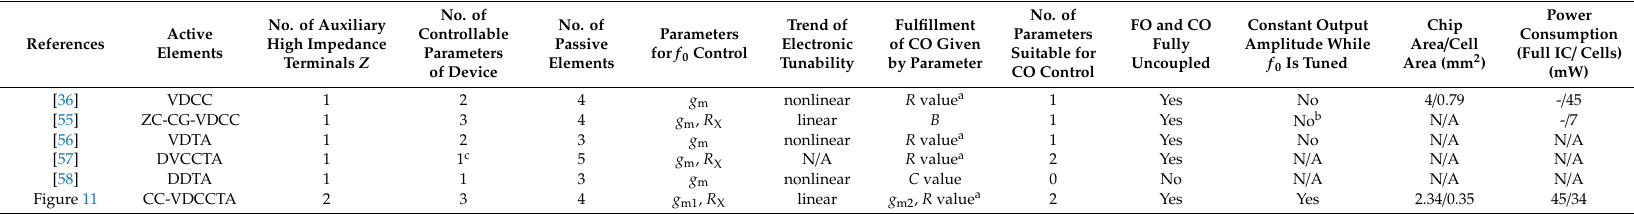
Table 2. A comparison of recently published and the most similar electronically controllable quadrature oscillators based on a single active element and a grounded